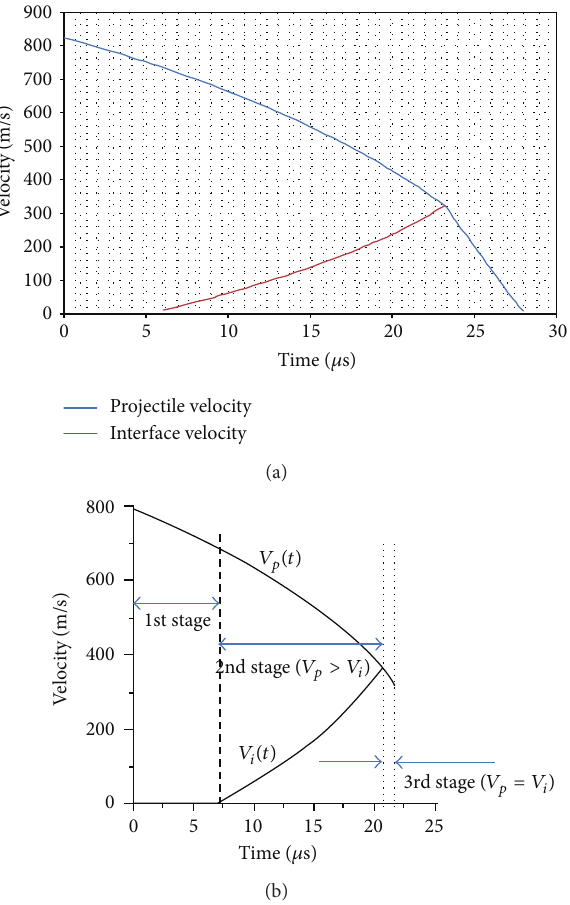
Figure 4: Velocity against time for (a) this work and (b) previous work [1, 2],